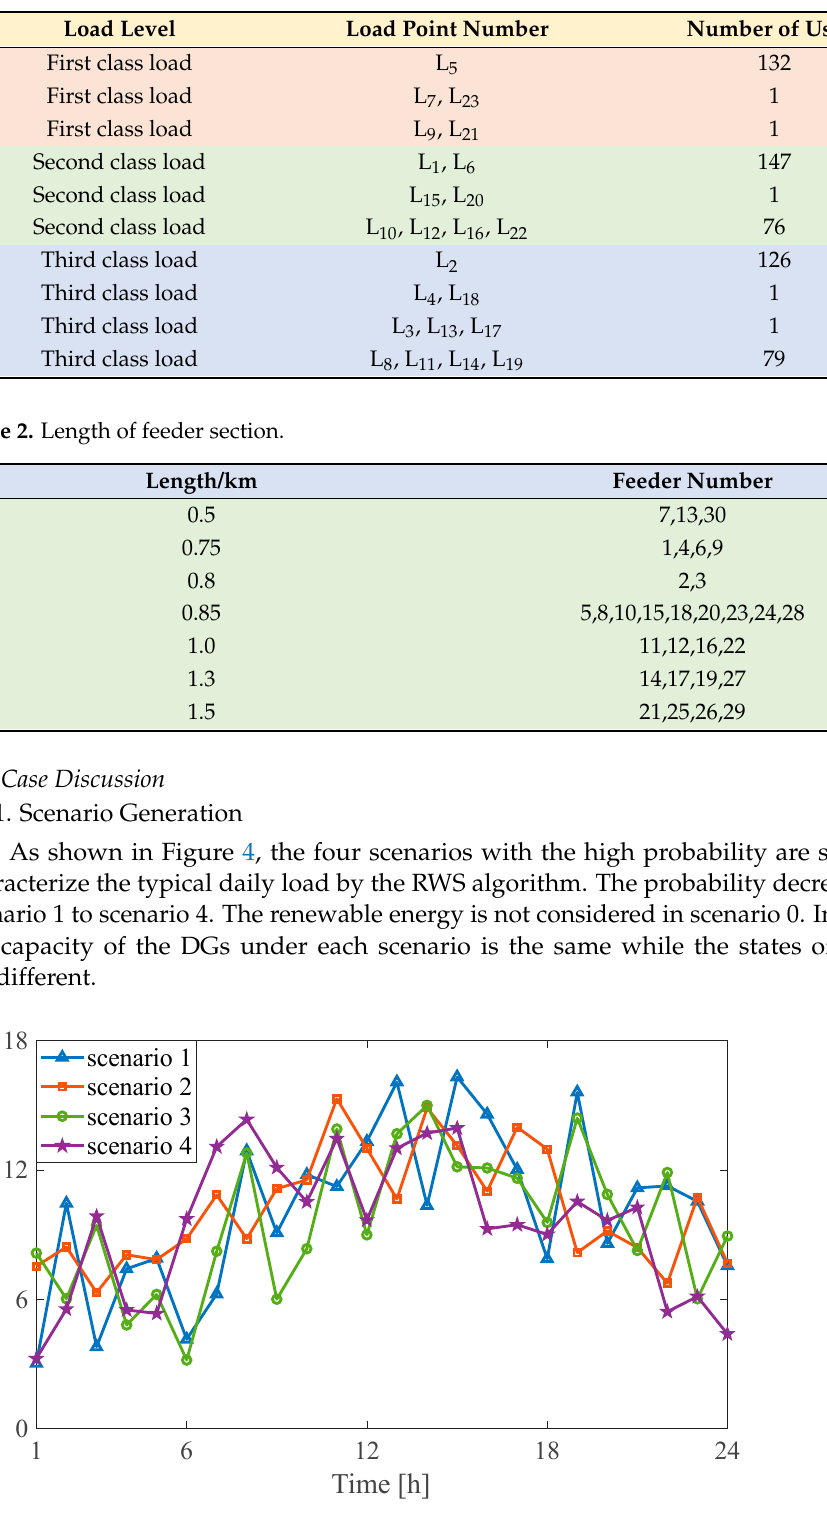
Figure 4. Load under typical scenarios.